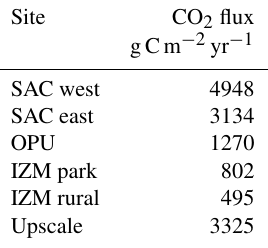
Figure 9. Relationship between the annual CO 2 flux ( F CO green fraction ( f G ) . The solid line represents a regression based on our flux data for Sakai, and the dashed line represents a relationship based on a global synthesis (Nordbo et al., 2012). Table 2. Annual CO 2 fluxes from the eddy covariance measure- ments and the upscaled city-scale